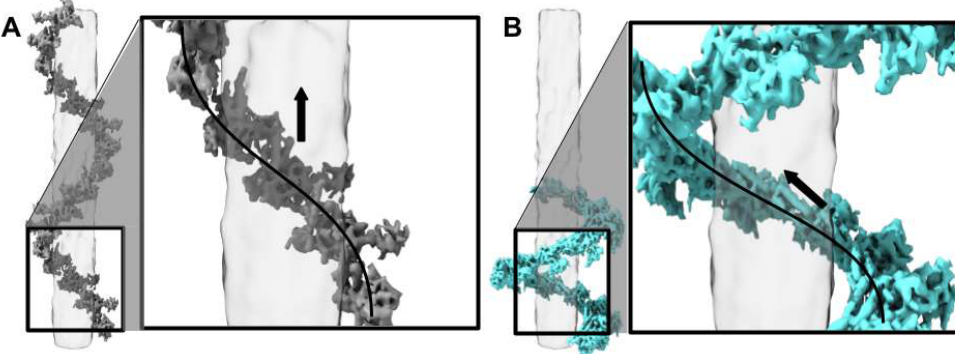
Figure 6. Tail contraction twists the orientation of individual phage G tail sheath subunits with no impact on intra-subunit structure: ( A ) non-contracted; ( B ) contracted. There are contacts with two long alpha helices in the inner density of the tail sheath (grey) in parallel with the tube (transparent grey). The arrow indicates the direction of the two alpha helices. In the contracted state, sheath proteins twist approximately 30º. In both ( A ) and ( B ) the phage head would be at the top of the